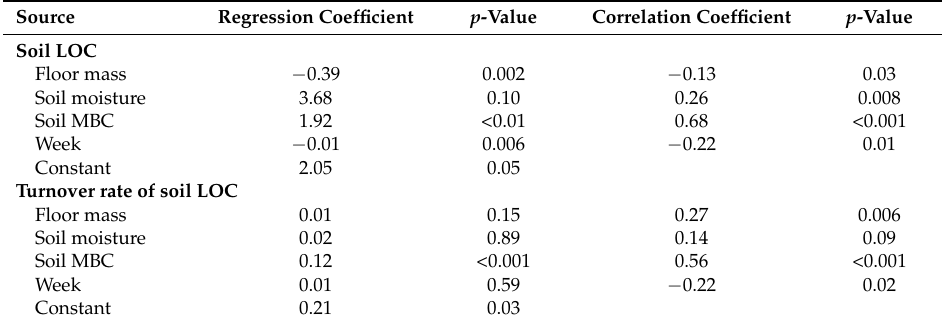
Table 3. Linear correlations of soil LOC and its turnover rate with floor mass, soil moisture, soil moisture, soil MBC, for the week after the CTDD treatment in the control and CTDD plots in the Luquillo Experimental Forest, Puerto